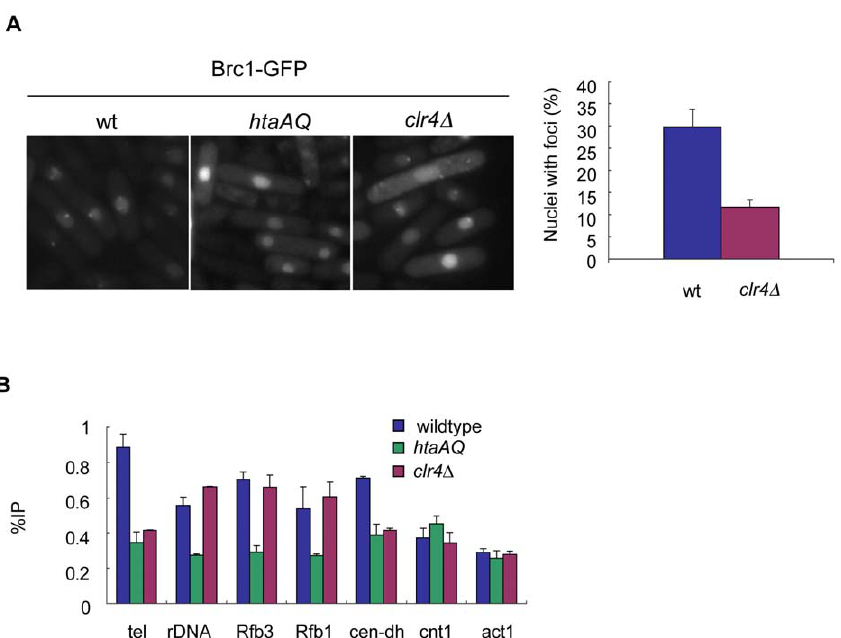
Figure 8. Brc1 recruitment to c H2A sites is partially dependent on Clr4. (A) Spontaneous Brc1-GFP foci are reduced in clr4 D mutants. Live cell microscopy of Brc1-GFP overexpressed using the nmt promoter in wild type, htaAQ , and clr4 D cells. There is no foci formation in the htaAQ mutant. Graph shows quantitated foci in the indicated strains. (B) Brc1 binds at c H2A sites, and Brc1 association with the telomeres and centromeres is reduced in clr4 D mutants. ChIP to sites of Brc1-GFP overexpressed from the nmt promoter at c H2A-sites in the indicated strains. Cell cultures were asynchronous. Primer locations were described in Figure 2C and Figure 5B.